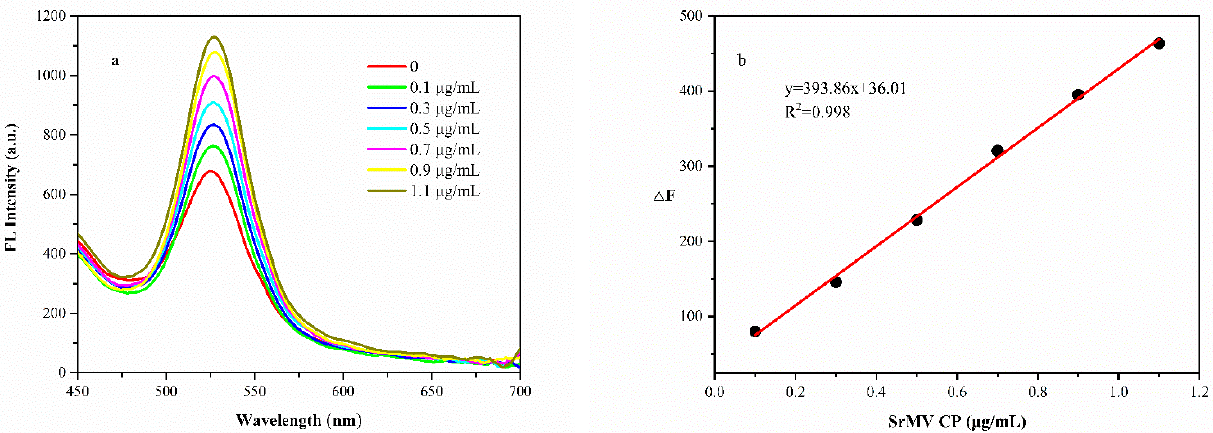
Figure 8. ( a ) The effect of CP concentrations on the fluorescent intensity of the developed biosensor; ( b ) Standard curve of the developed biosensor ( △ F = F t − F 0 ).